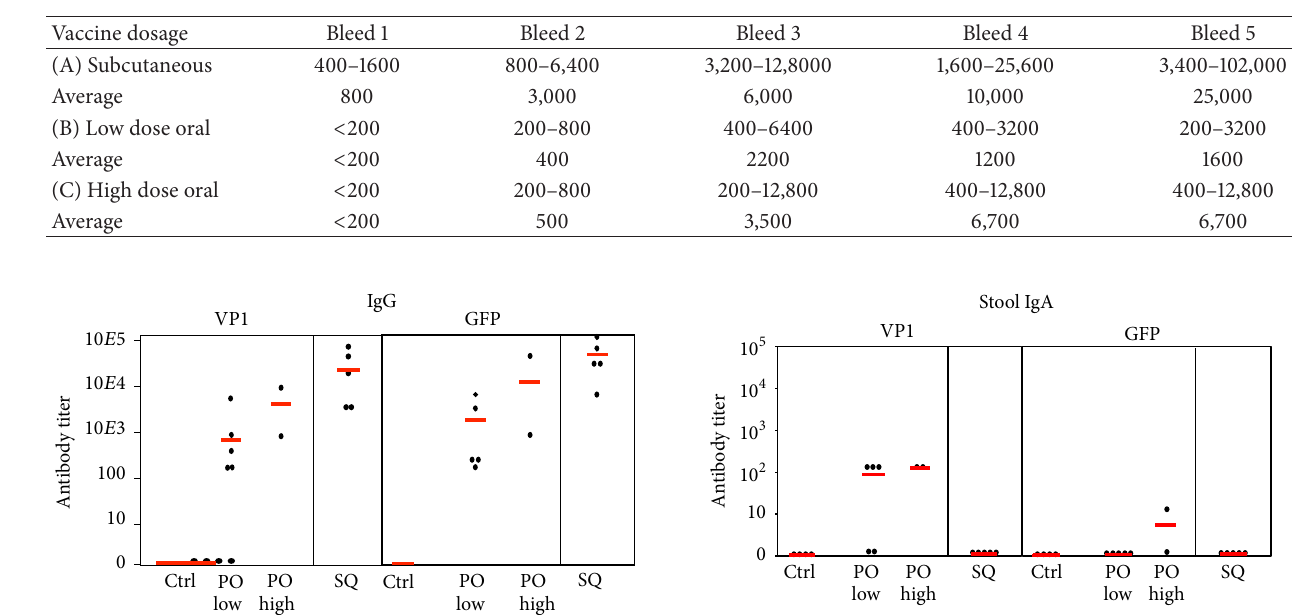
Figure 14: IgA responses to VP1 and GFP in stools at day 56. Mouse groups are as described in Figure 13. Red lines indicate mean